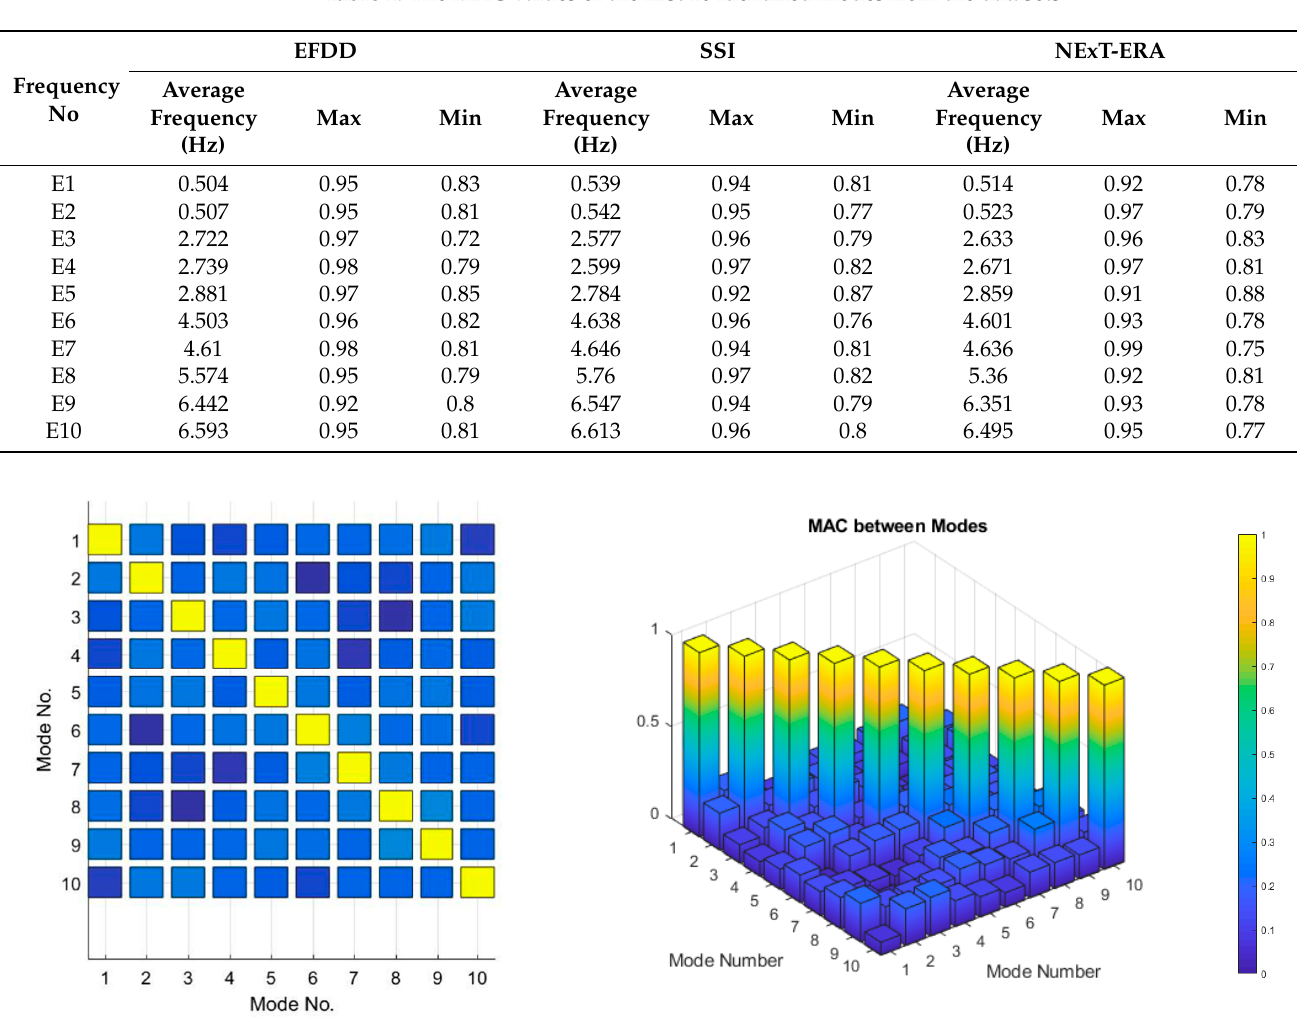
Figure 8. A typical MAC matrix between the identified modes (EFDD).